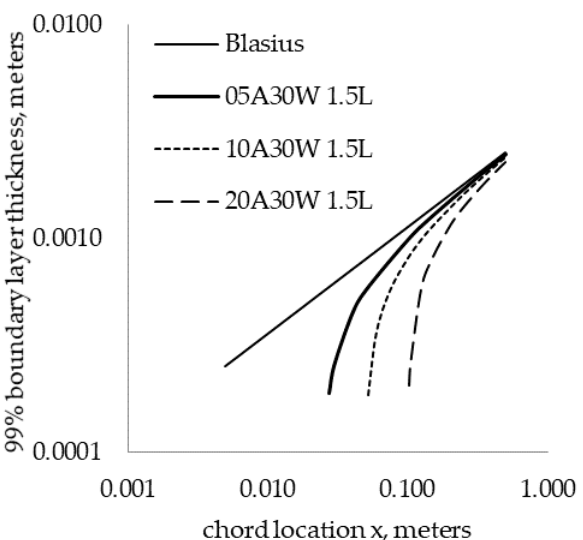
Figure 11. Base flow boundary layer thicknesses for di ff erent leading-edge amplitudes at the wavy LE trough.